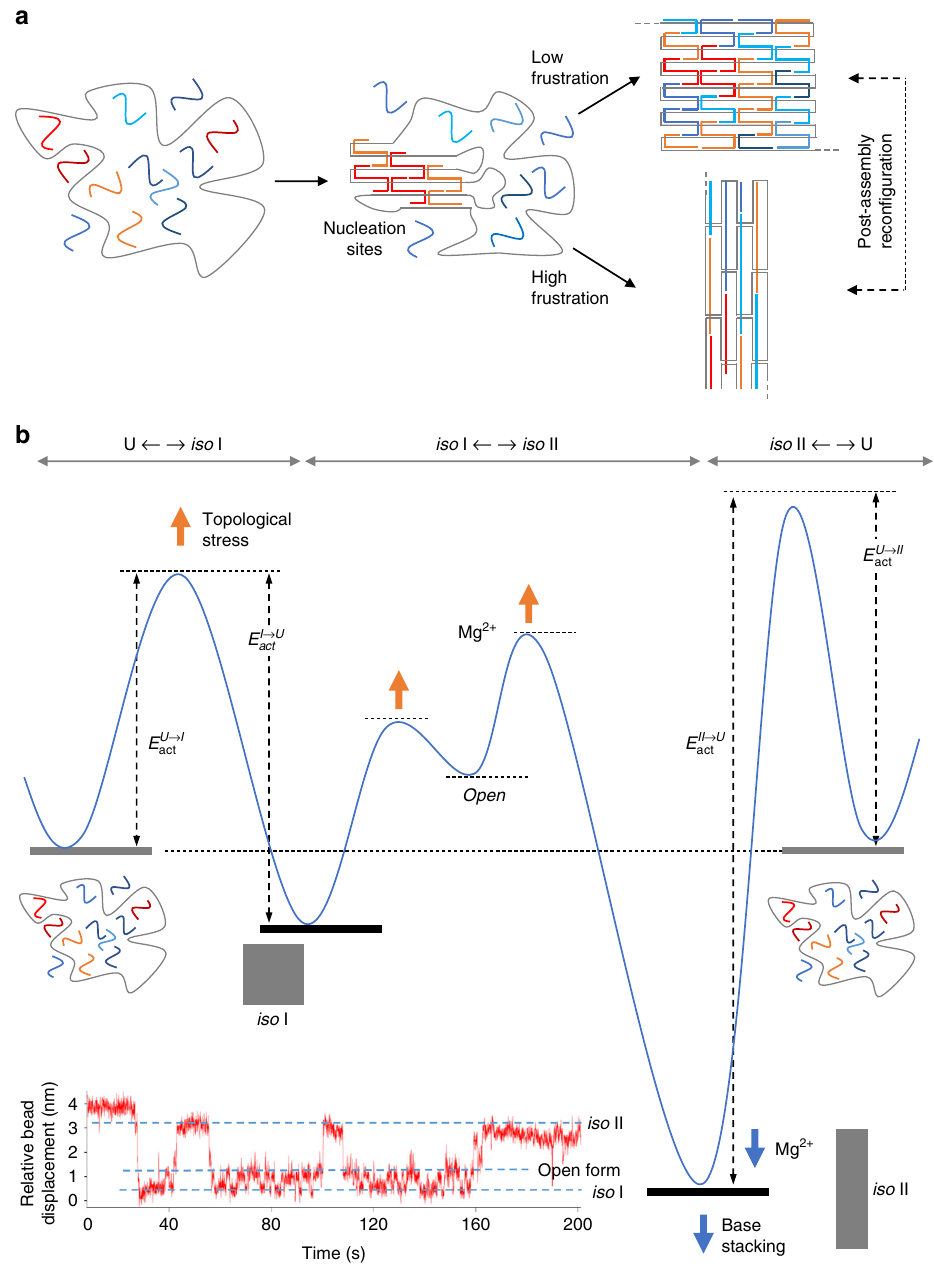
Fig. 5 Energy landscape of DNA origami assembly. a In our proposed dynamic model of DNA origami folding, the fi nal fate is dictated by the degree of topological stress experienced at the nucleation sites. Besides the formation of the iso I state, favored by a low level of structural frustration, this mechanism enables to travel an alternative folding pathway leading to a typically less populated iso II state, which becomes competitive for structurally frustrated nucleation sites. b Assembly pathway of domain A in the e(2) design according to the values of activation energy for the cooling and melting of both the iso I and iso II isomers. The energy landscape is representative of a DNA origami assembly with two possible outcomes, connected by a post- assembly recon fi guration that passes through an intermediate open form, as shown by single-molecule force spectroscopy measurements (inset). The energy barriers for folding/unfolding of the iso I species are lower than those of the iso II, resulting in the easier formation and reversibility of the former and large hysteresis of the latter. The lower rate of iso II formation might be due to the entropic penalty and elastic energy cost associated to its folding. Here, the scaffold is entangled into a highly ordered structure constituted by many duplexes shorter than the persistence length of double-stranded DNA. Nevertheless, once the kinetic barrier is passed, the energy gain appears to be large enough to reach an absolute minimum from which the structure cannot easily escape. The energy level associated to the open form has been set arbitrarly and is not matter of this study. Note the two-fold effect of magnesium ions on the energy landscape of connected HJs: increasing Mg 2 + concentrations lead to a decrease in the iso I/ iso II conversion rate (orange arrows, previous studies 29 ) and stabilization of the iso II form (blue arrows, this